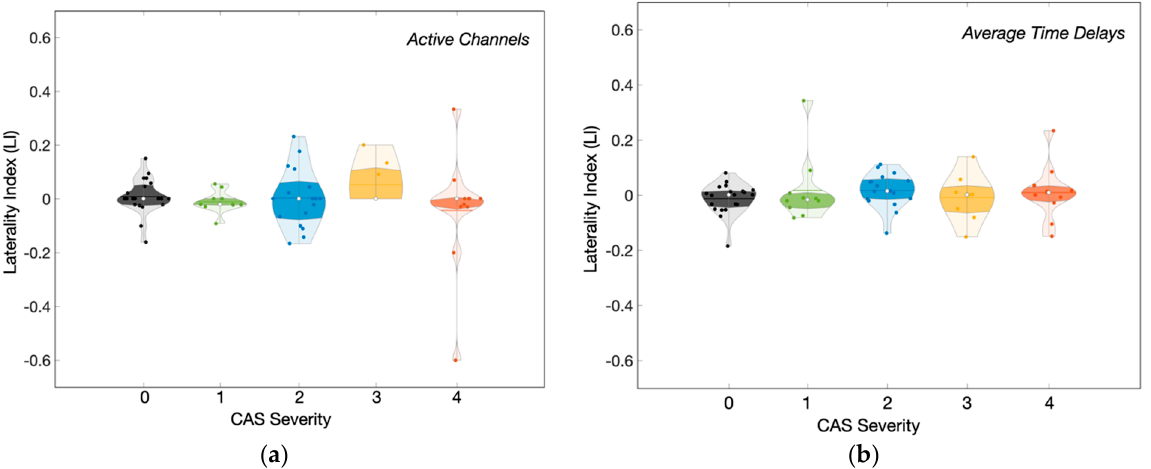
Figure 7. Distribution of the laterality index (LI) as a function of the carotid artery stenosis (CAS) calculated for ( a ) the fraction of active channels that responded to the breath − holding challenge and the ( b ) time delays of the vasodilatory hemodynamic response to breath − holding. Gray: Control, green: unilateral level 1, blue: unilateral level 2, yellow: bilateral level 3 and, orange: bilateral level 4.